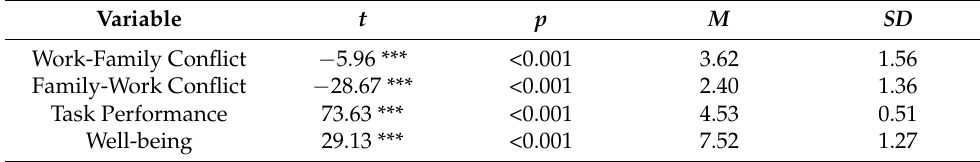
Table 2. Descriptive statistics of the variables under study.